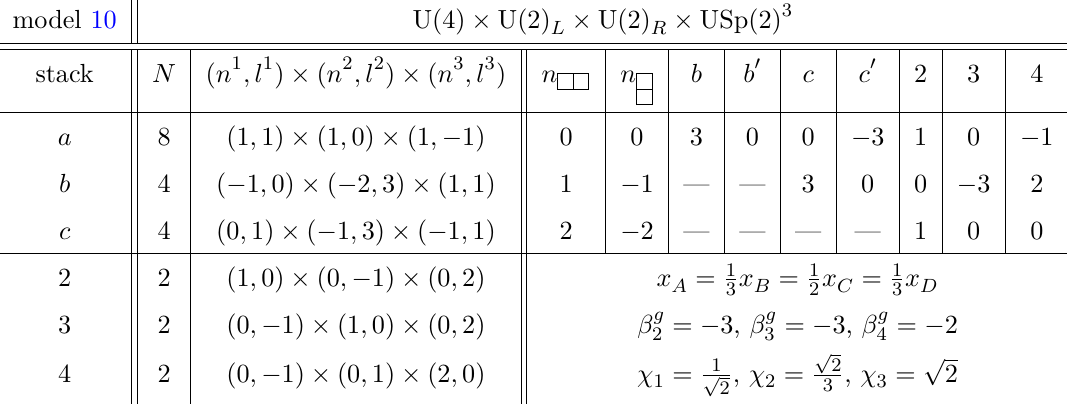
Table 10 . D6-brane configurations and intersection numbers of Model 10, and its MSSM gauge